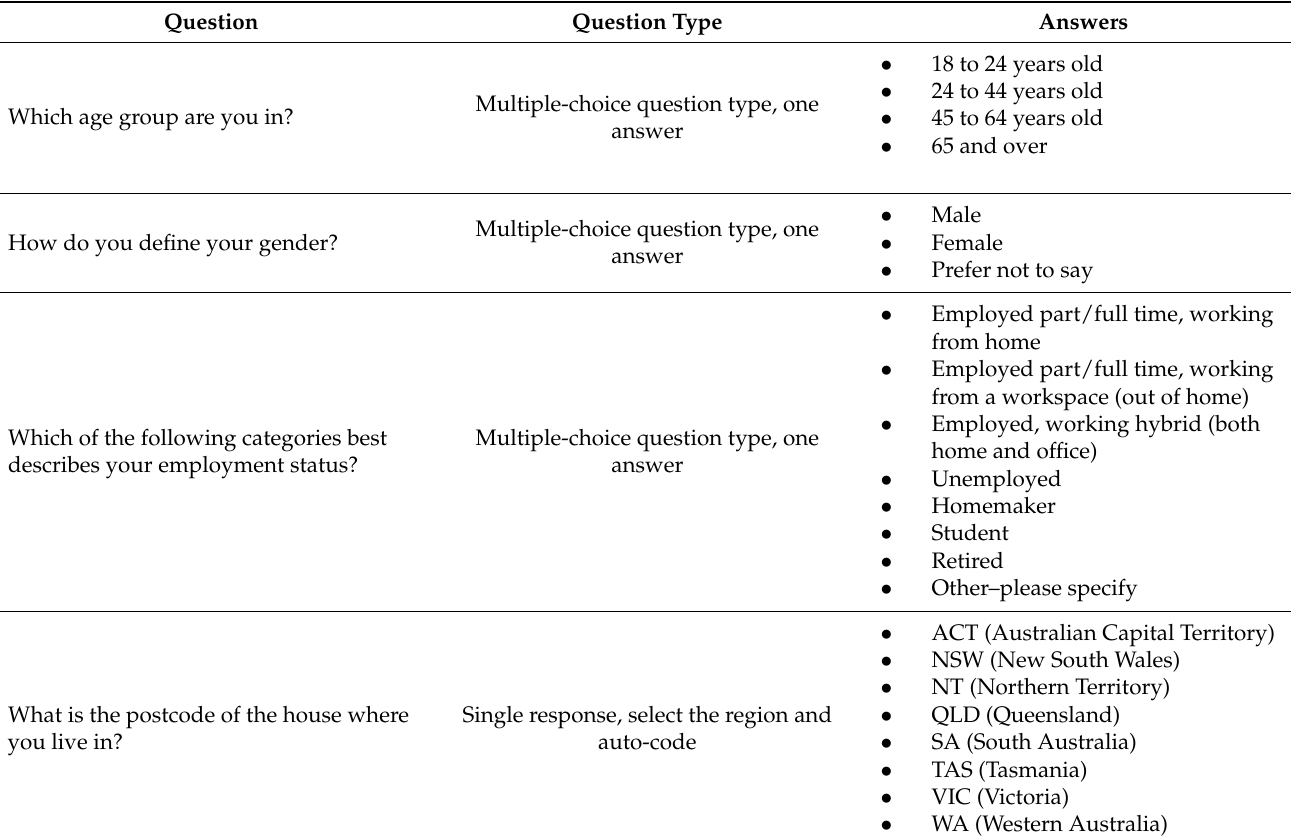
Table 1. Questionnaire items: Descriptive